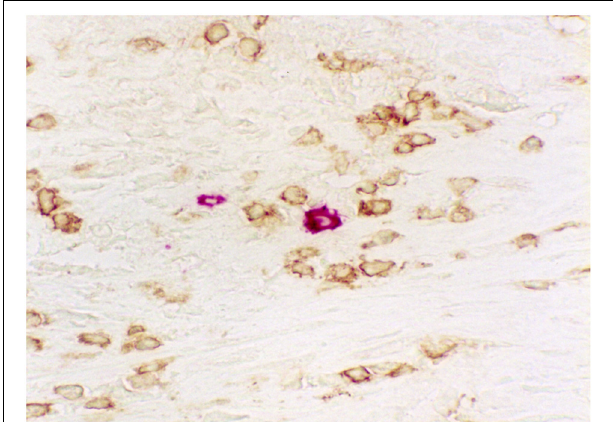
FIGURE 4 | Immunohistochemical visualization of close proximity of pDCs (rose) to T cells (brown) in an area of human aortic atherosclerotic plaque containing immune-inflammatory infiltrate. Double immunostaining: pDCs were visualized using anti- BDCA-2 antibody (CD303; Miltenyi Biotec) while T cells were visualized using anti-CD3 antibody (Dako). A combination of peroxidase-antiperoxidase and alkaline phosphatase-antialkaline phosphatase immunotechniques using 3-Amino-9-ethylcarbazole (AEC) substrate and diaminobenzidine (DAB). Magnification: ×